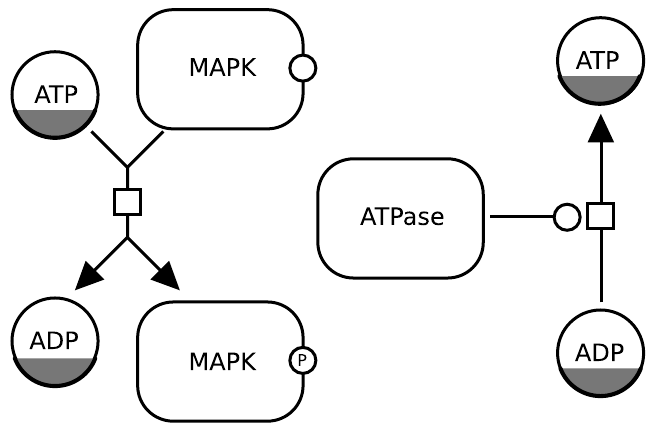
Figure 2.7: An example of using cloning, here for the species ATP and